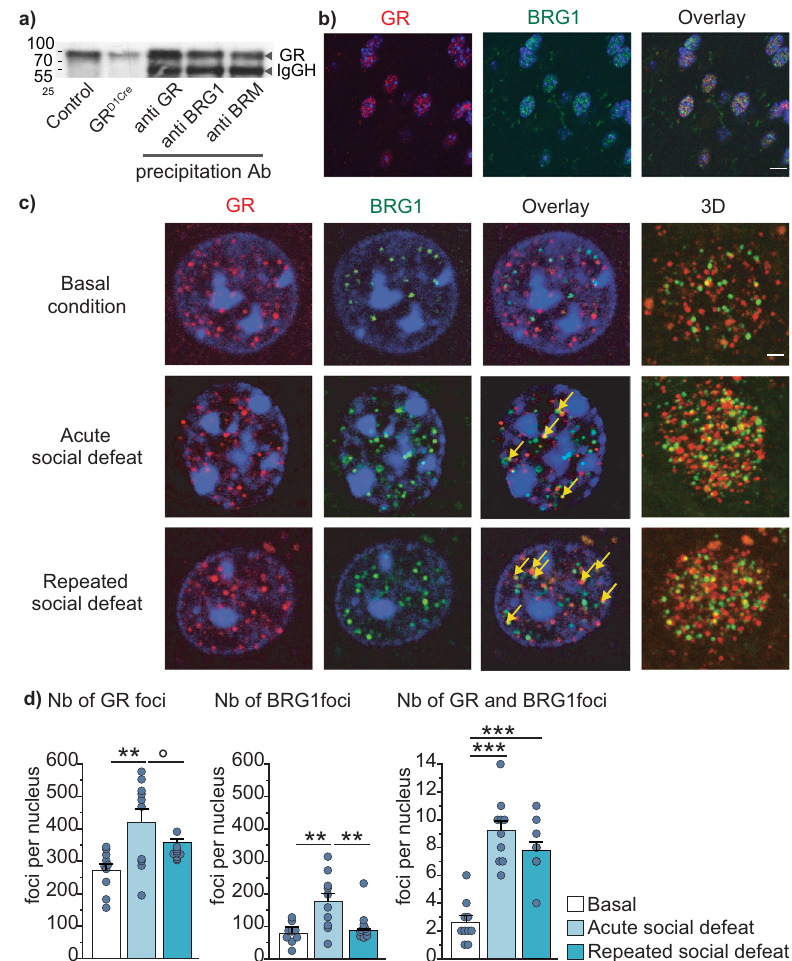
Fig. 1 Colocalization of BRG1 and GR within the nucleus accumbens under basal conditions or after stress exposure. a Co-immunoprecipitation of GR, BRG1, and BRM in whole striatum protein extracts. Lanes 1 and 2 correspond to GR detection in whole striatum lysates from GR loxP/loxP control mice and GR D1Cre mice respectively. Lanes 3, 4, and 5 correspond to GR detection after immunoprecipitation with GR, BRG1, and BRM antibodies, respectively. Left, molecular weight (kDa), IgGH, Immunoglobulin Heavy Chain b Co-staining of GR (in red), BRG1 (in green) and DNA (in blue, DAPI) in nuclei within the NAc. Scale bar = 20 μ m. c High magni fi cation of GR (red), BRG1 (green) and DAPI (blue) co-staining in a NAc MSN nucleus in an undefeated mouse (basal condition), 1 hour after an acute social defeat or 24 h after 10 days of repeated social defeats. The three fi rst columns correspond to one focal for GR-DAPI, BRG1-DAPI and overlay stainings with the yellow bars pointing at foci in which BRG1 and GR colocalize. The last column corresponds to the nuclei 3D images. Scale bar = 2 μ m. d Quanti fi cation of GR (left chart; treatment effect F(2,29) = 8.91, p = 0.003), BRG1 (middle chart; treatment effect F(2,29) = 10.30, p = 0.0005) and both GR and BRG1 colocalization foci (right chart; treatment effect F(2,29) = 32.07, p < 0.0001) in MSNs of the NAc from undefeated mice (basal), 1 h after an acute social defeat, or 24 hours after repeated (10 days) social defeat. n = 10 nuclei in 4 mice per condition. One- way ANOVA followed by Bonferroni correction, left panel: ° p = 0.0898, ** p = 0.0024; middle panel: **basal vs acute p = 0.0012, **acute vs repeated p = 0.0023; right panel *** p < 0.0001. Data are represented as mean ± s.e.m. Data are provided in a Source Data fi